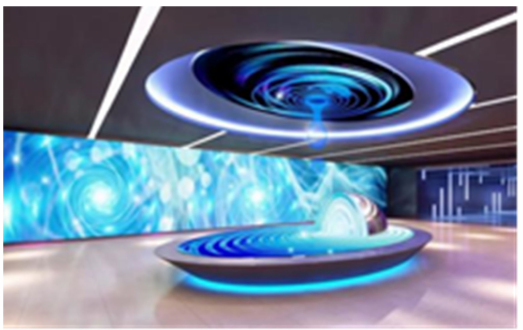
Figure 13. “Water Court” in Huaqiang North Metro Commercial Street,